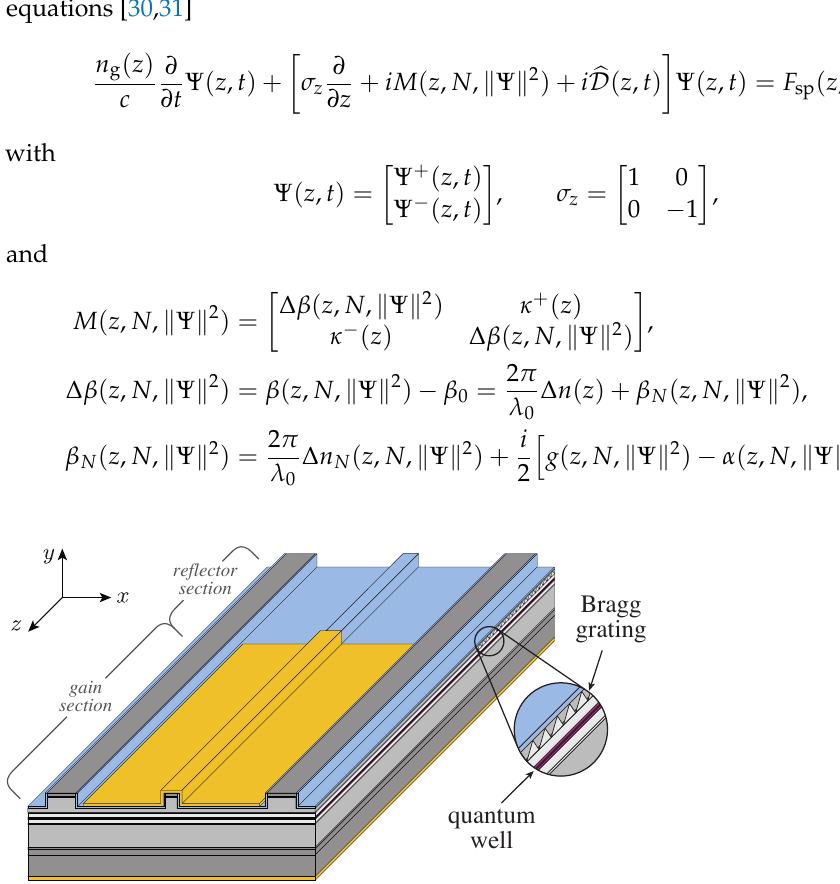
Figure 1. Schematic view of a two-section DBR laser consisting of an electrically biased gain section and a passive Bragg reflector section, exemplifying an edge-emitting multi-section semiconductor